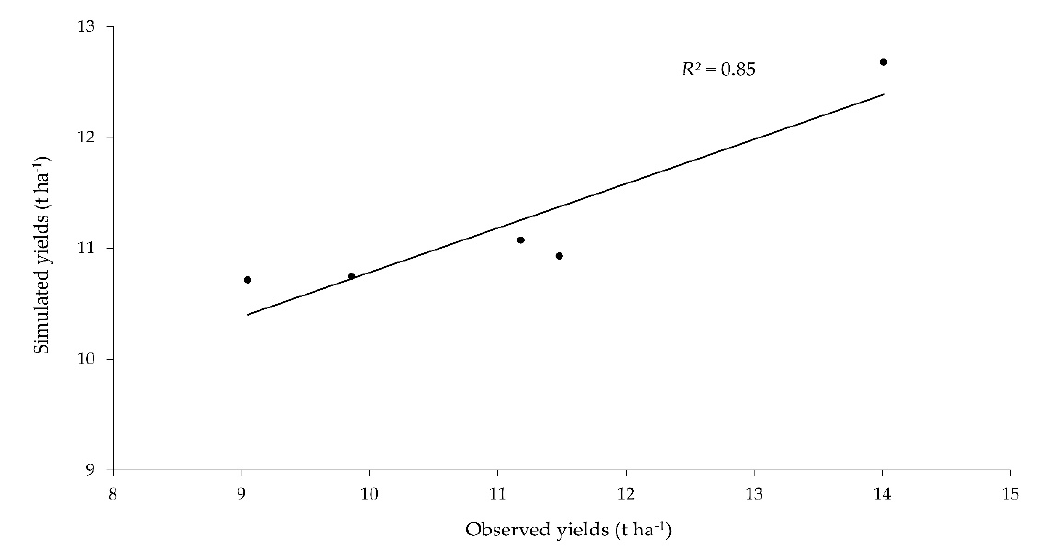
Figure 7. Linear regression of simulated crop yields (t ha − 1 ) on observed maize yields for the validation period. Table 5. Mean simulated and observed maize grain yield in tonnes per hectare (t ha − 1 ), Nash–Sutcliffe Efficiency (NSE) and root-mean-square error (RMSE) and PBIAS for the validation simulation.